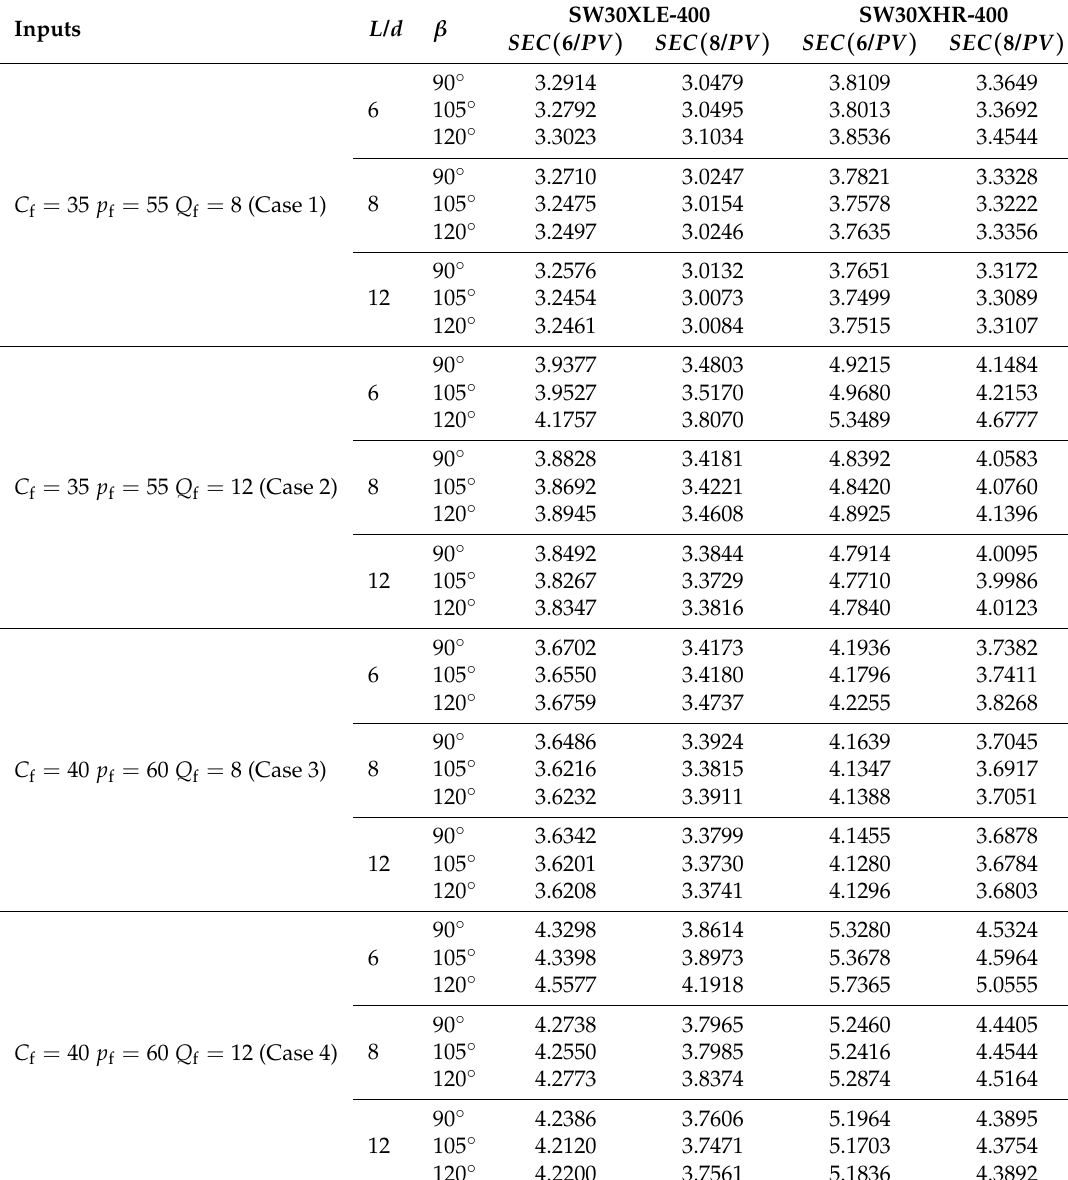
Table 4. SEC (kWh m − 3 ) for PVs of 6 and 8 SWMMs with the two membranes studied with different